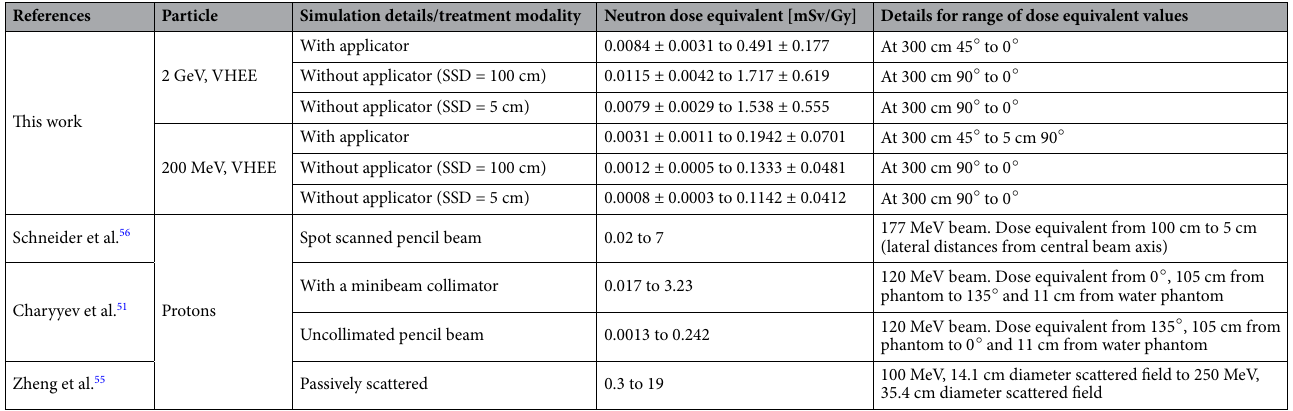
Table 2. Range of ambient neutron dose equivalent values for this work with a combined uncertainty (statistical type A, and 20% and 30% type B for variations due to physics options and conversion coefficients respectively), compared with other studies involving protons. The last column of the table provides details about each value in the dose equivalent range, such as the location of the calculation/measurement and beam